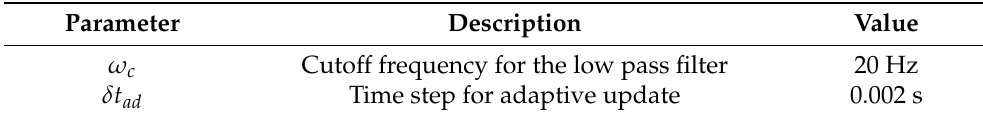
Table 4. Design parameters of L 1 adaptive control for lateral